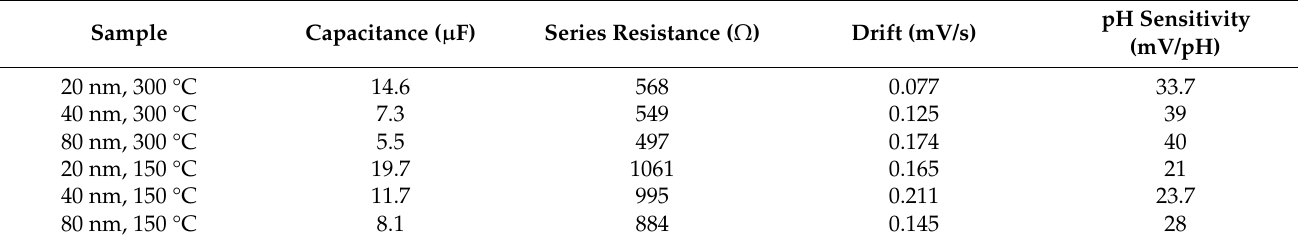
Table 1. Summary Table of the TiO 2 Coated Sample